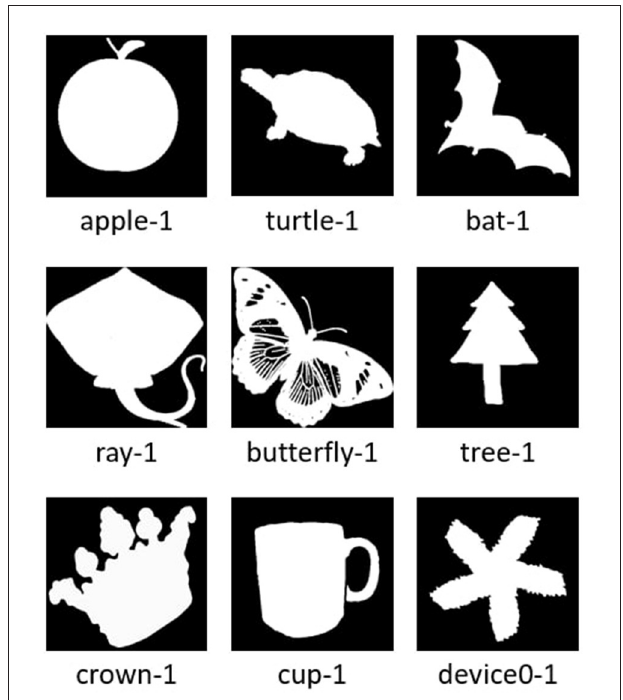
FIGURE 1 | Object/shape templates from the MPEG-7 core experiment CE-shape-1 test